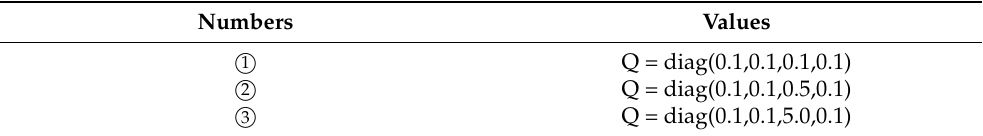
Table 2. Noise covariance Q